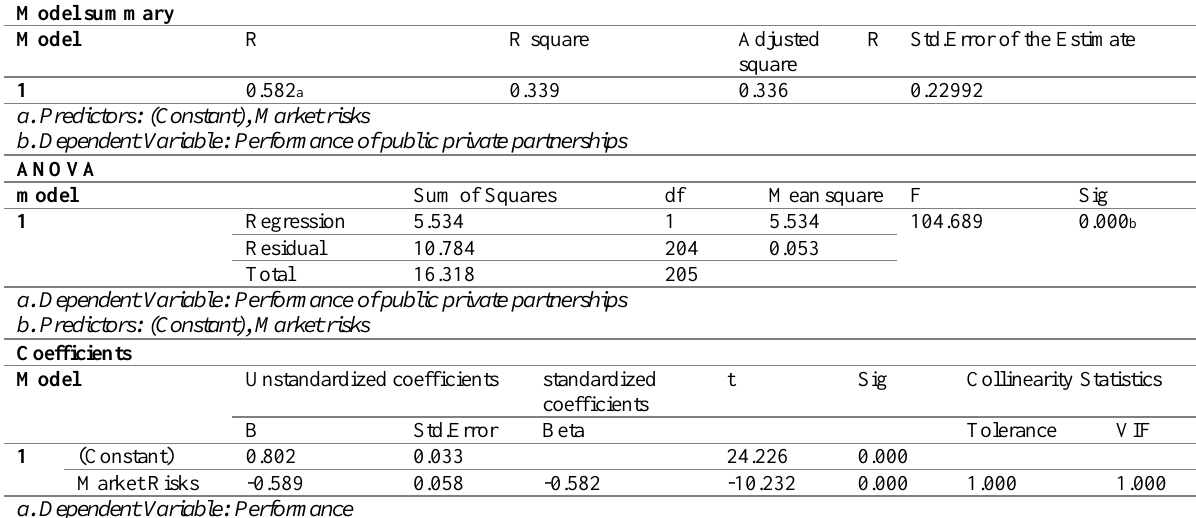
Table 7: Market risks and performance of public private partnerships renewable energy